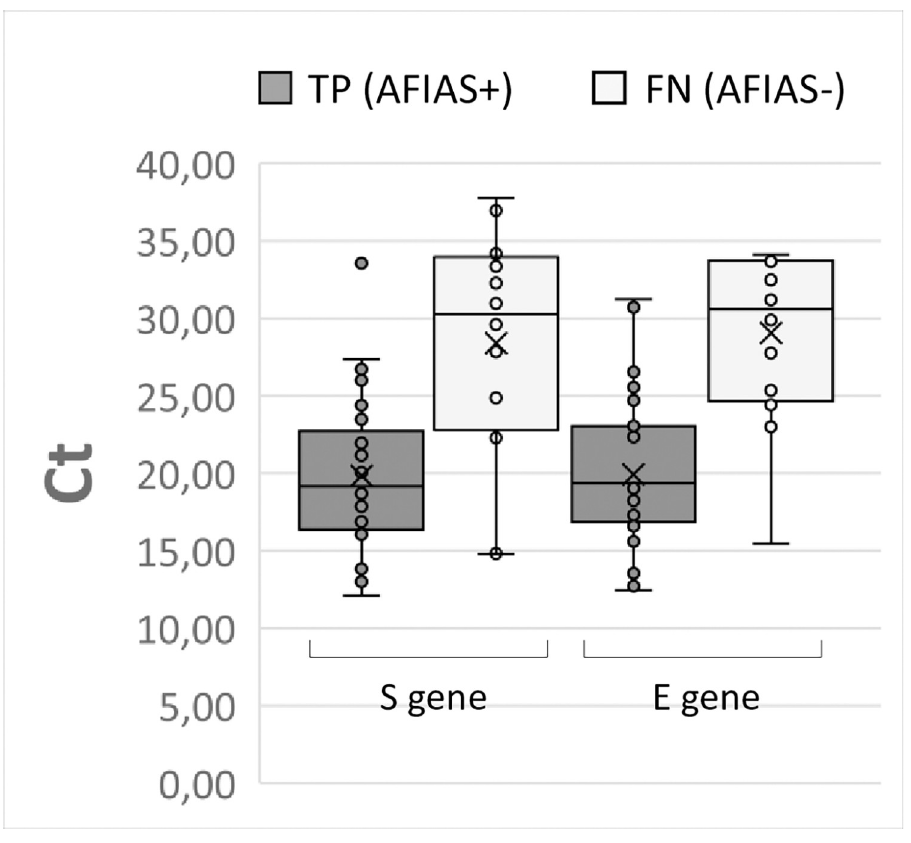
Fig 1. Box-plot distribution of Ct values obtained by RT-PCR targeted to the viral S gene and E gene from NP swab NPSs, broken down according to the result obtained by AFIAS COVID-19 Ag rapid test. AFIAS+: true- positive, TP; AFIAS-: false-negative, FN.